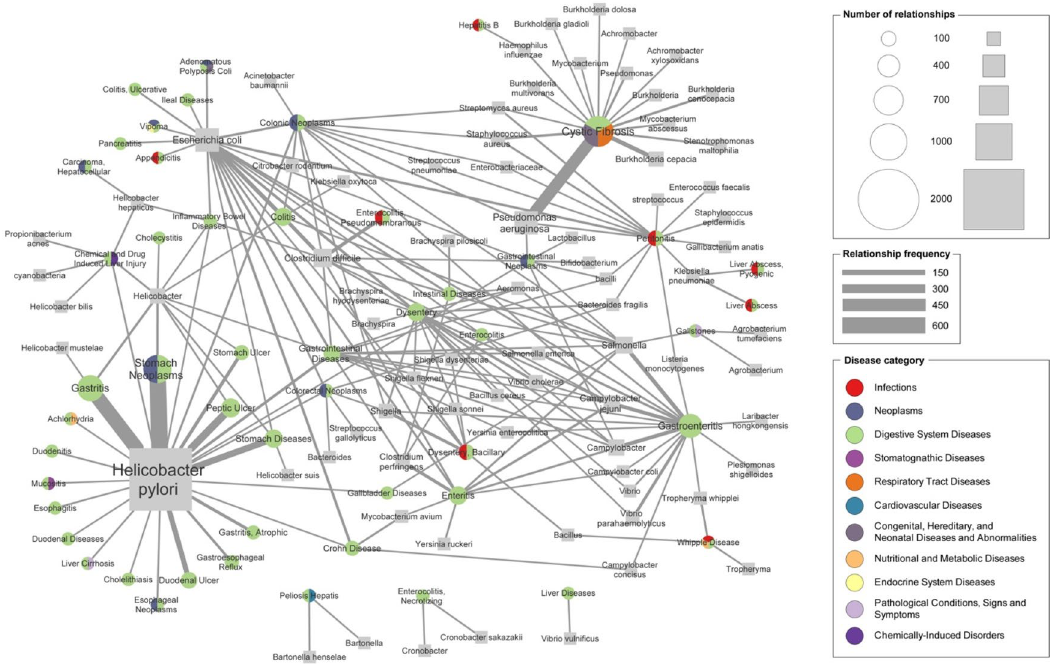
Figure 7. Network for digestive system diseases. A disease node (circle) and a microbe node (square) are connected by an edge when more than four relations are extracted. The size of node is proportional to the number of extracted relations between the disease or microbe, and the color of node represents top-level MeSH disease categories to which the disease belongs. The width of edge is proportional to the frequency at which the relation is